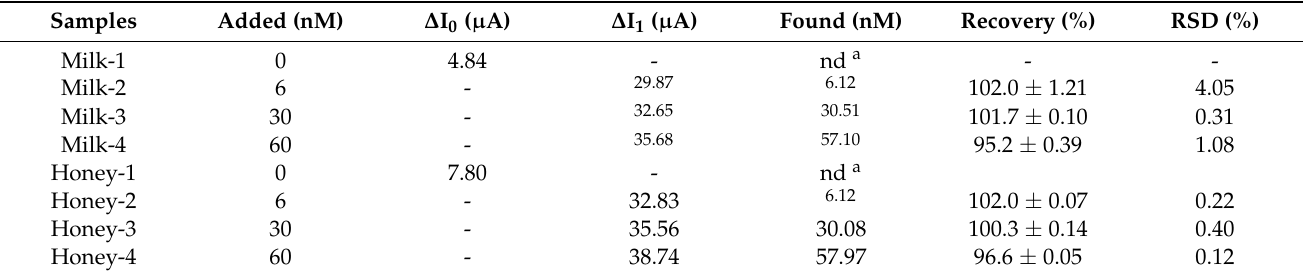
Table 3. Results of NOR detection in real food samples ( n =